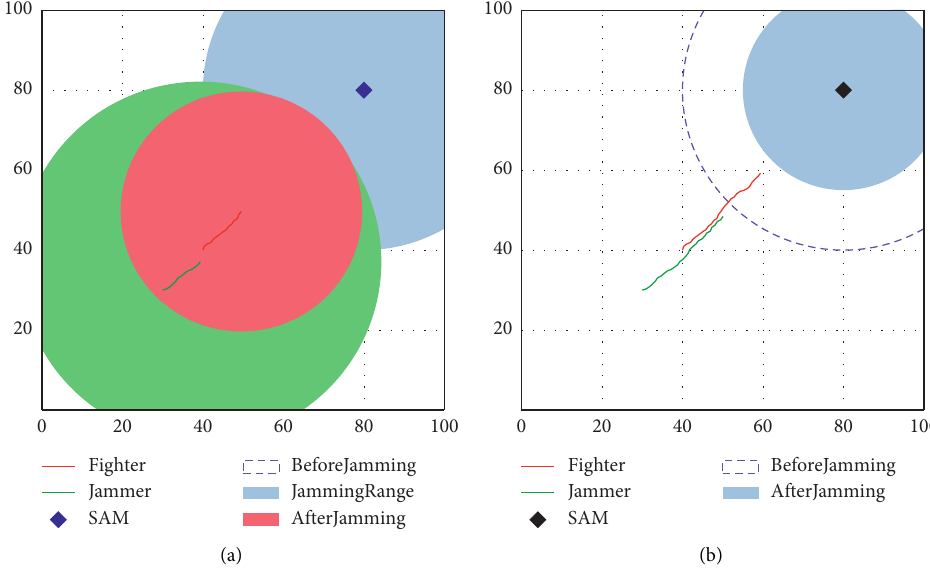
Figure 9: (a) Fighter and jammer flight cooperatively; (b) jammer jamming the Sam to reduce the weapon range, and the fighter takes the opportunity to attack the Sam. When the Sam is destroyed, it turns